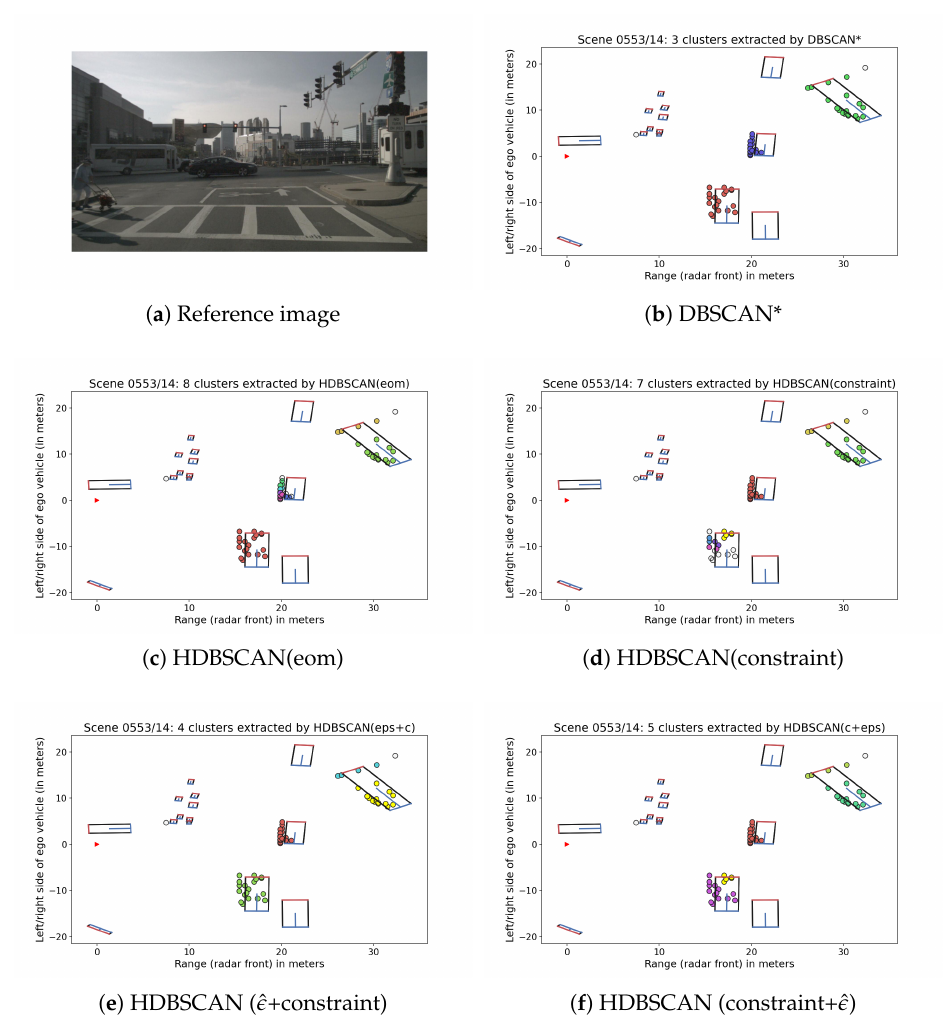
Figure 3. Reference image from nuScenes [24] and clustering results for a sample in Scene